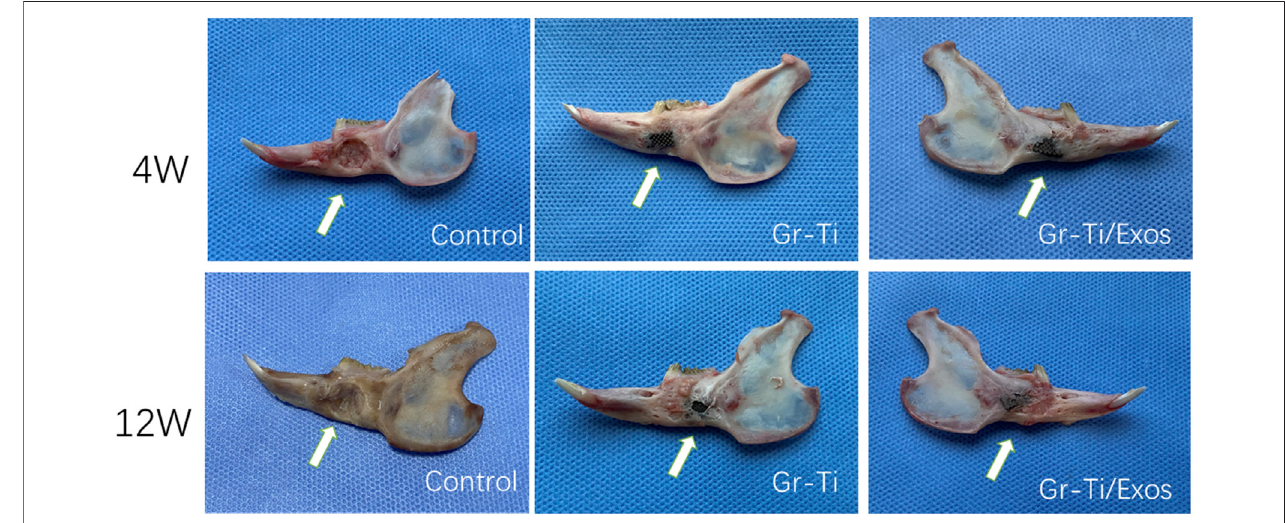
FIGURE 10 | General observation of scaffold materials.